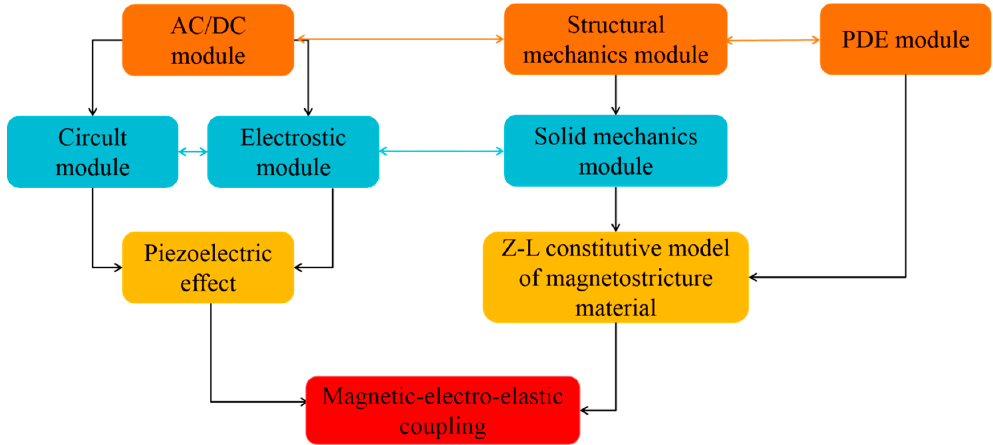
Figure 2. The relationships between the magnetic-electro-mechanical coupling of each module.